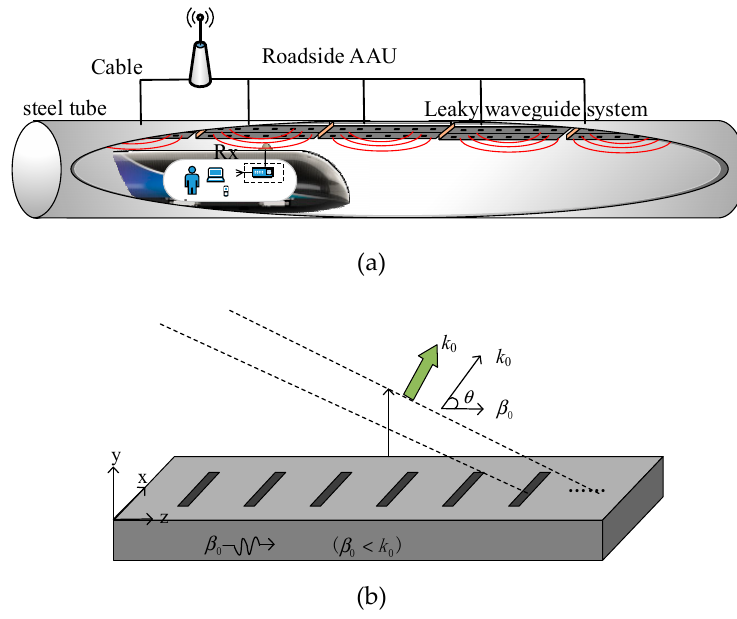
Figure 3. The leaky waveguide system: ( a ) a schema; ( b ) the radio propagation direction.